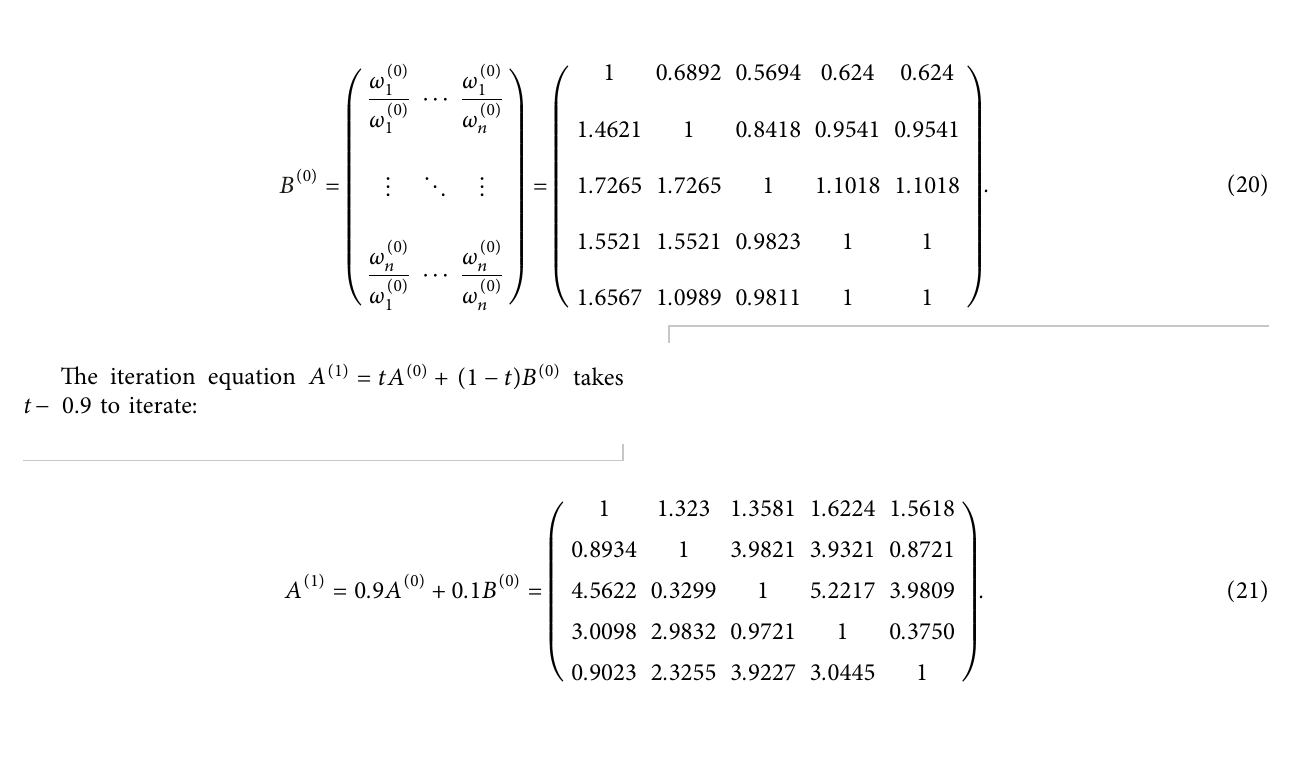
Figure 2: Comprehensive quality level